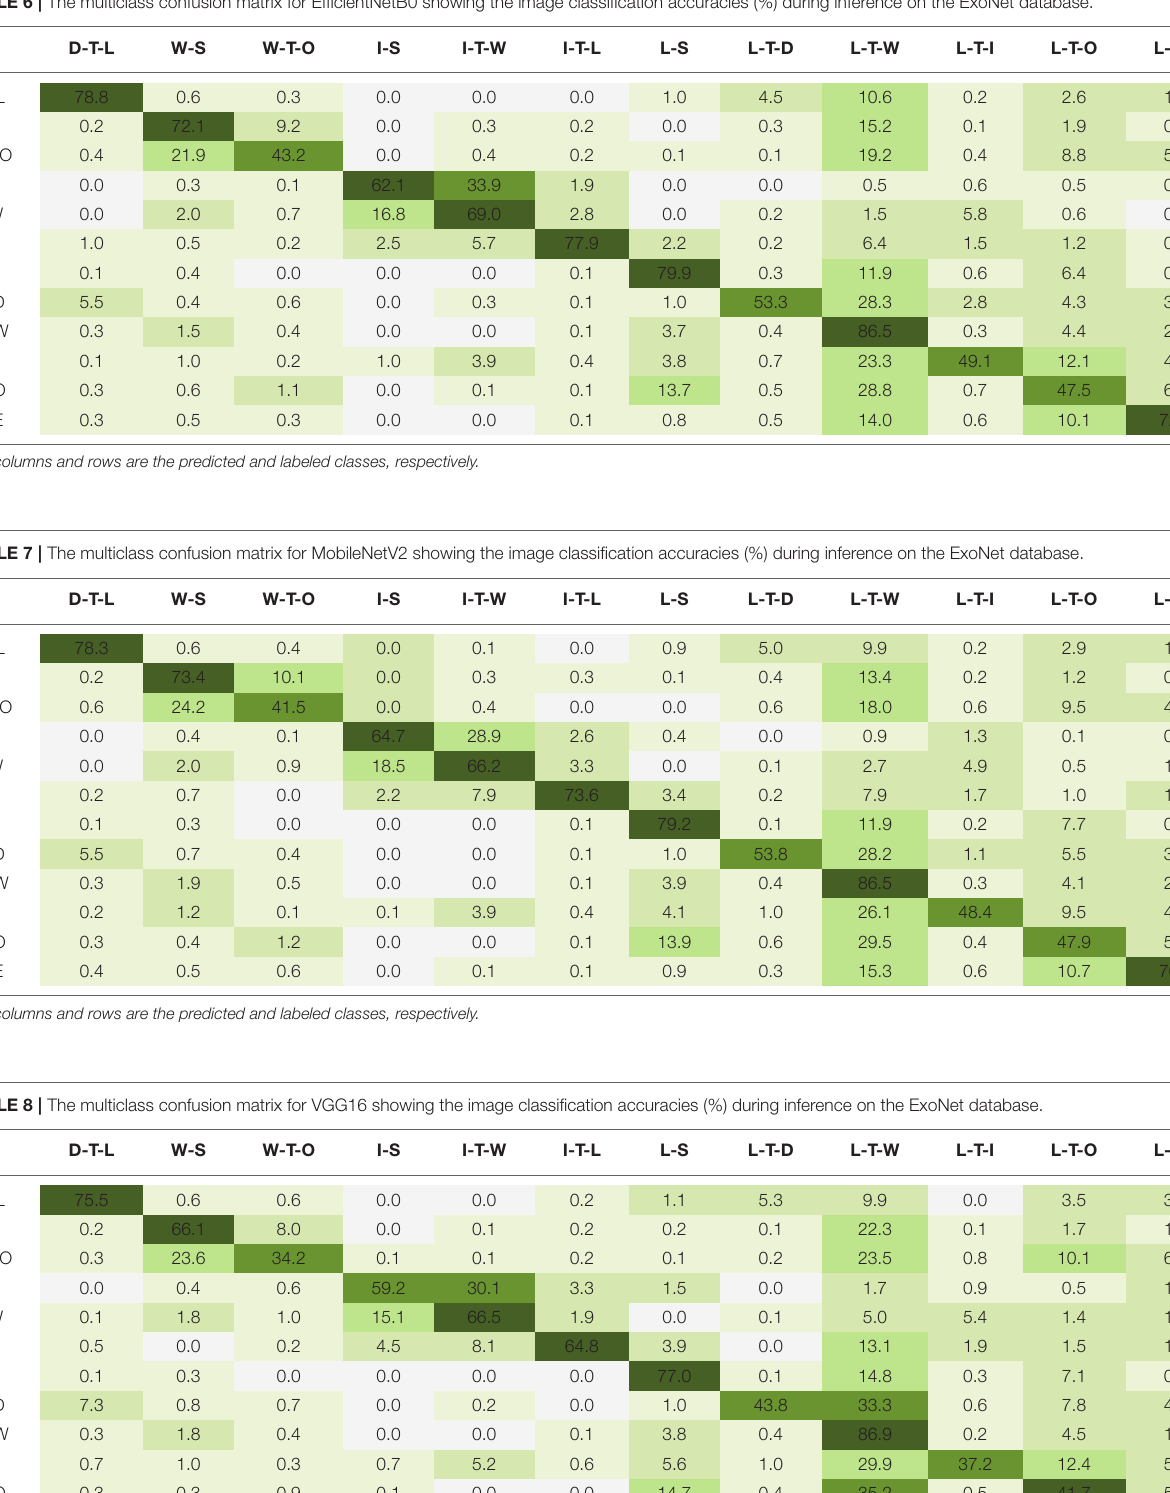
TABLE 6 | The multiclass confusion matrix for EfficientNetB0 showing the image classification accuracies (%) during inference on the ExoNet database.